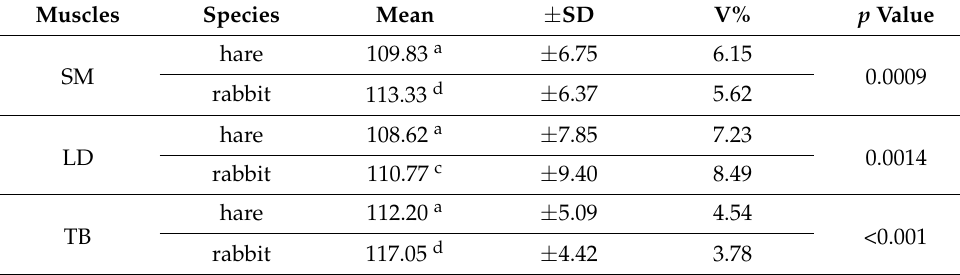
Table 2. Gross energy content in hare and rabbit meat (kcal/100